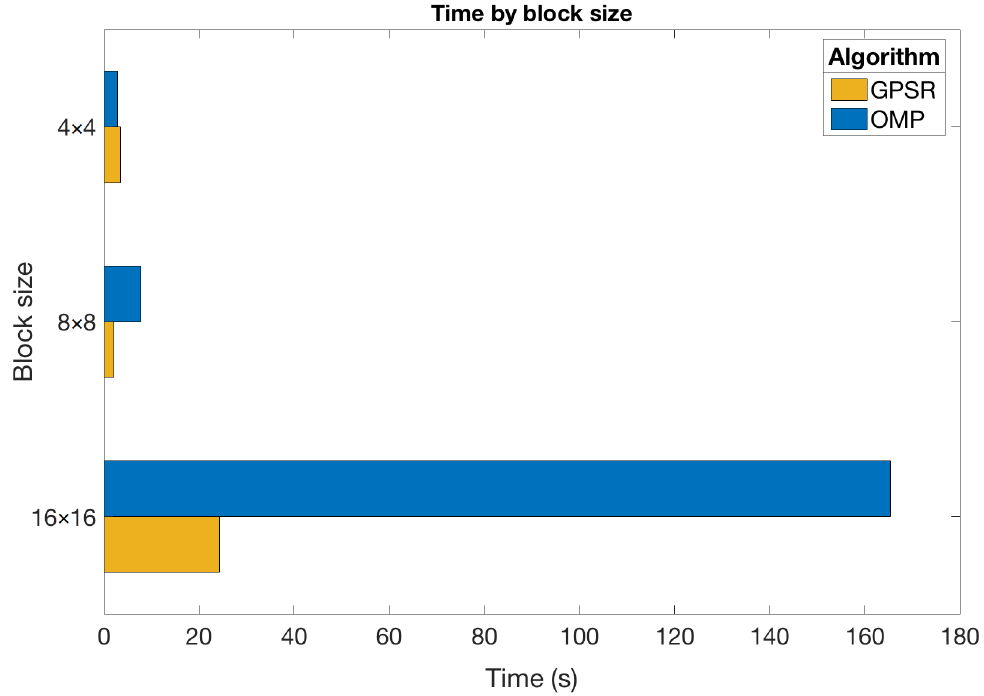
Figure 10. Execution time with different block sizes. Table 2. Execution time (in seconds) required for the image reconstruction with N s = 2 shots, the DCT basis, and considering different algorithms and block